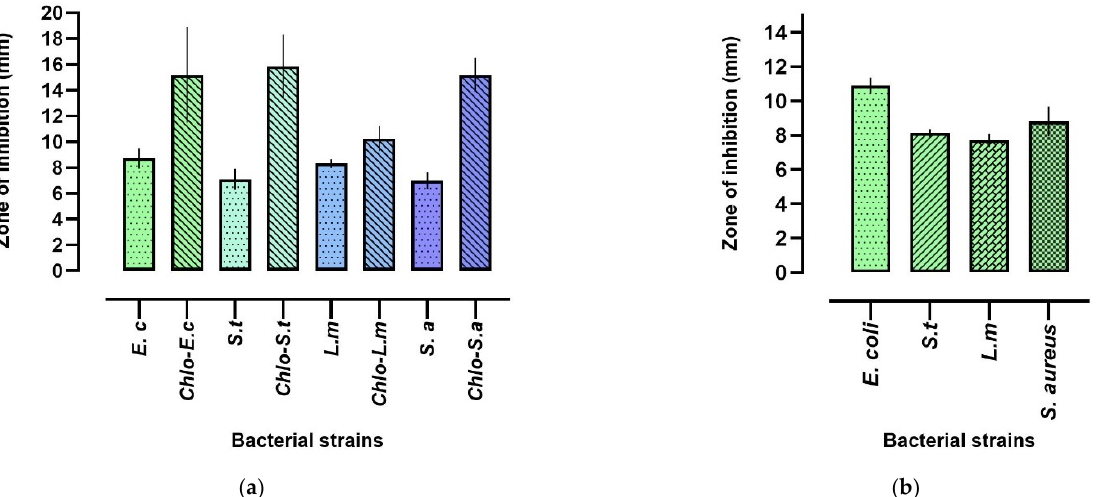
Figure 8. ( a ) Diffusion halo results of VO(IV)- bis (abietate) solution, compared to chloramphenicol (Chlo) control. ( b ) Diffusion halo results of VO(IV)- bis (abietate) dispersed in paint.